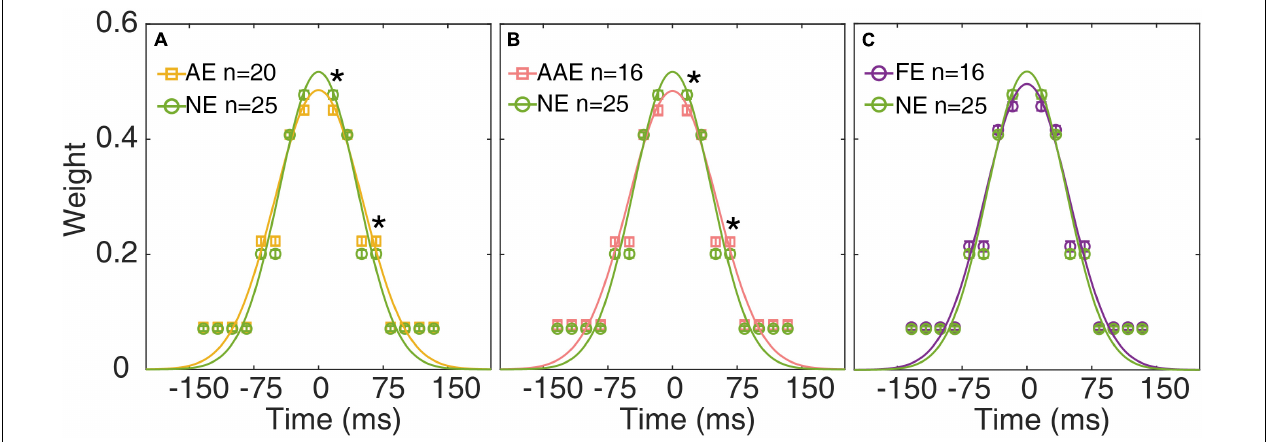
FIGURE 5 | The average temporal weights of the best-fitting ePTM of the AE (yellow), AAE (pink), and FE (purple) are plotted as functions of time in (A–C) , respectively. The average temporal profile of the NE (green) is also plotted in each panel. Error bar : ± 1 standard error. *: p < 0.05. The continuous curves are the best-fitting Gaussians.